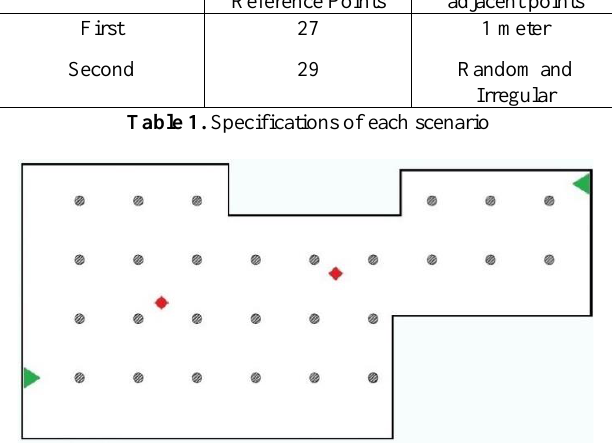
Figure 3 . The map of the building and the distribution of reference points in scenario 1 (Gray circles are reference points, green triangles are access points and red diamonds are target points)